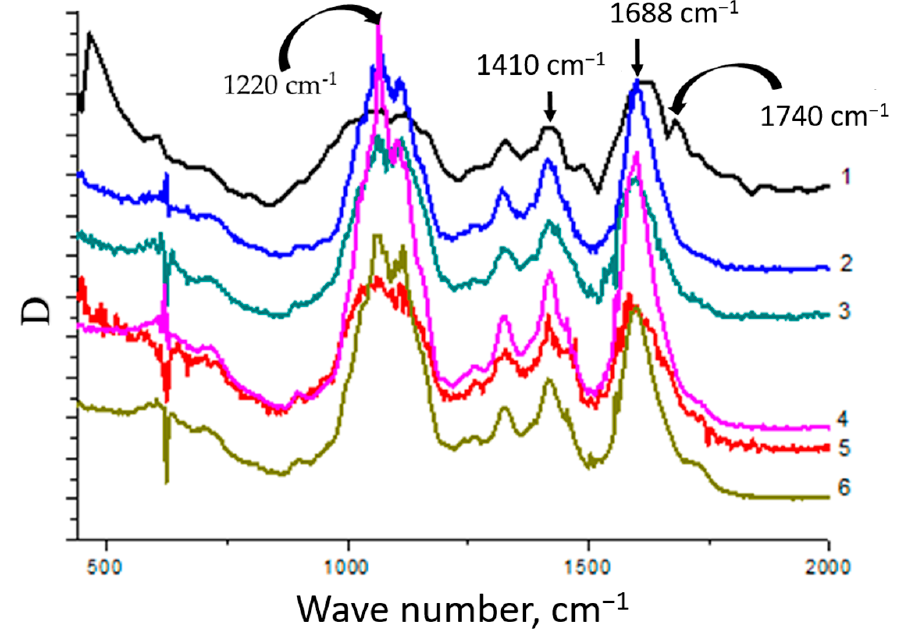
Figure 7. IR spectra of cerium-containing products based on CMC: pure CMC ( 1 ), composite with 6.4 wt.% Ce 4+ ( 2 ); composite with 7.1 wt.% Ce 4+ ( 3 ); composite with 9 wt.% Ce 4+ ( 4 ); composite with 11.0 wt.% Ce 4+ ( 5 ); composite with 14.1 wt.% Ce 4+ ( 6 ).